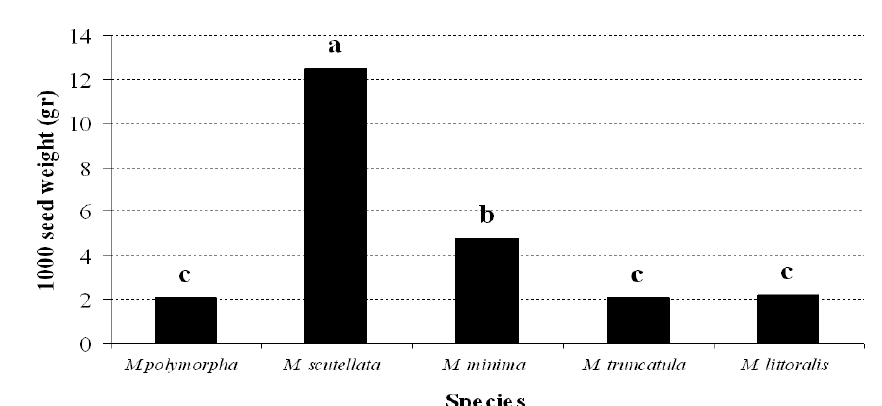
Fig. 10. Main effects of species on 1000 seed weight. All the values followed by the same letter in each column are not statistically different at the p<0.05 probability level